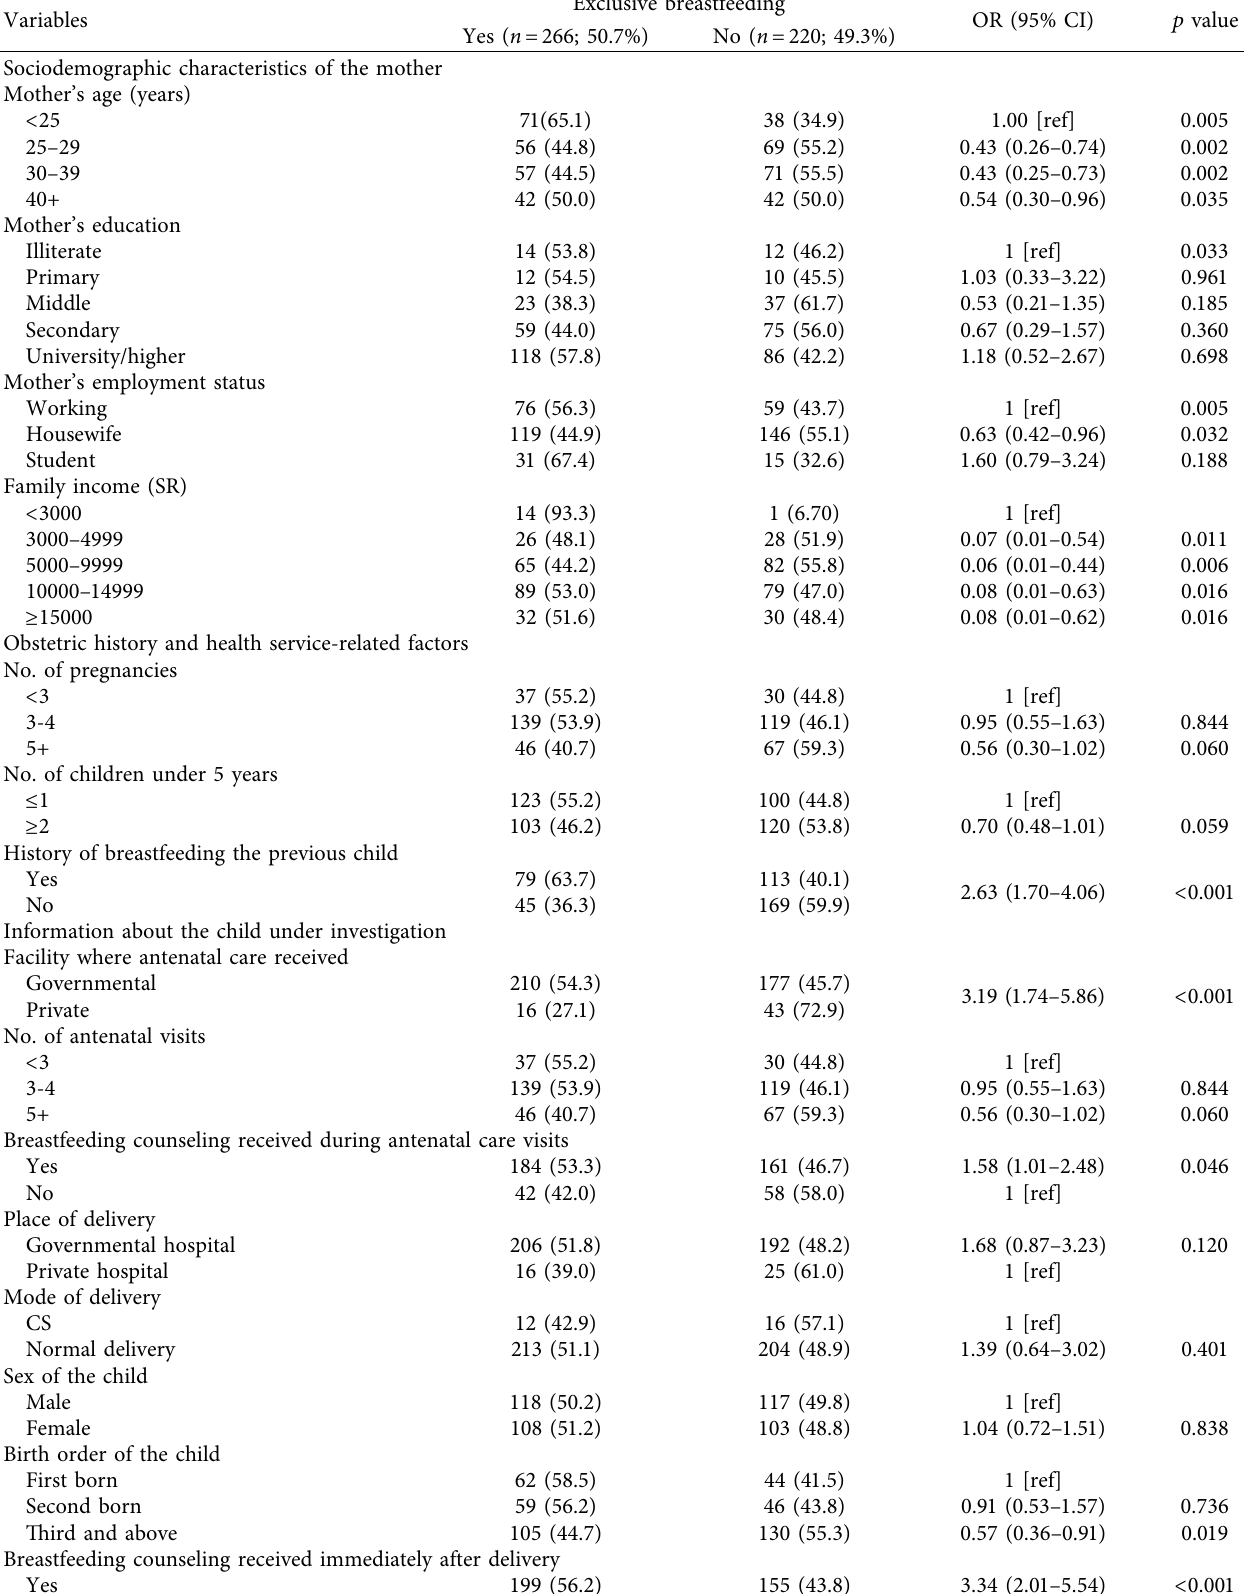
Table 2: Bivariate analysis of factors associated with exclusive breastfeeding (EBF) practice among mothers in Hail city, Saudi Arabia, 2019. Variables